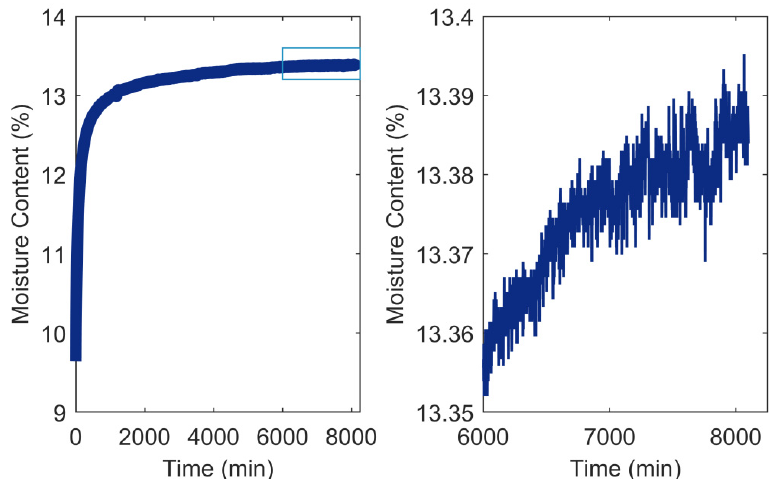
Figure 1. Example of sorption kinetic data for loblolly pine ( Pinus taeda L.) after a change in relative humidity (RH) from 70% to 80% (data from [8]). The rectangle in the left figure is expanded in the right figure, revealing small but nonzero changes in moisture content that occur over long periods of time until equilibrium is achieved, which is defined as a mass change on the scale of the inherent mass stability of the instrument (less than 2 µg over 24 h).